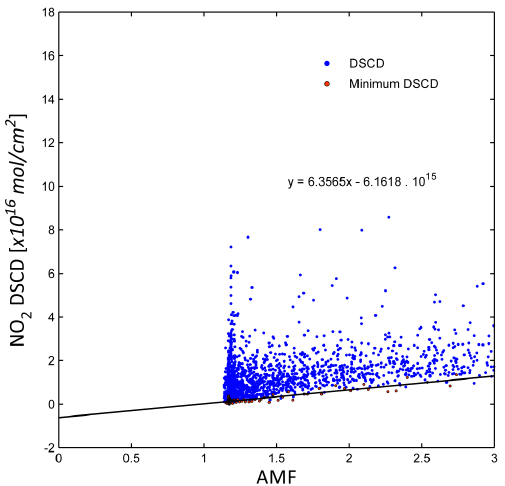
Figure 2. A value of 6.2 × 10 15 moleccm − 2 is determined for the residual amount in the reference spectrum (RSCD) based on appli- cation of the MLE method. The ZS noon spectrum was selected on 21 June 2009 at